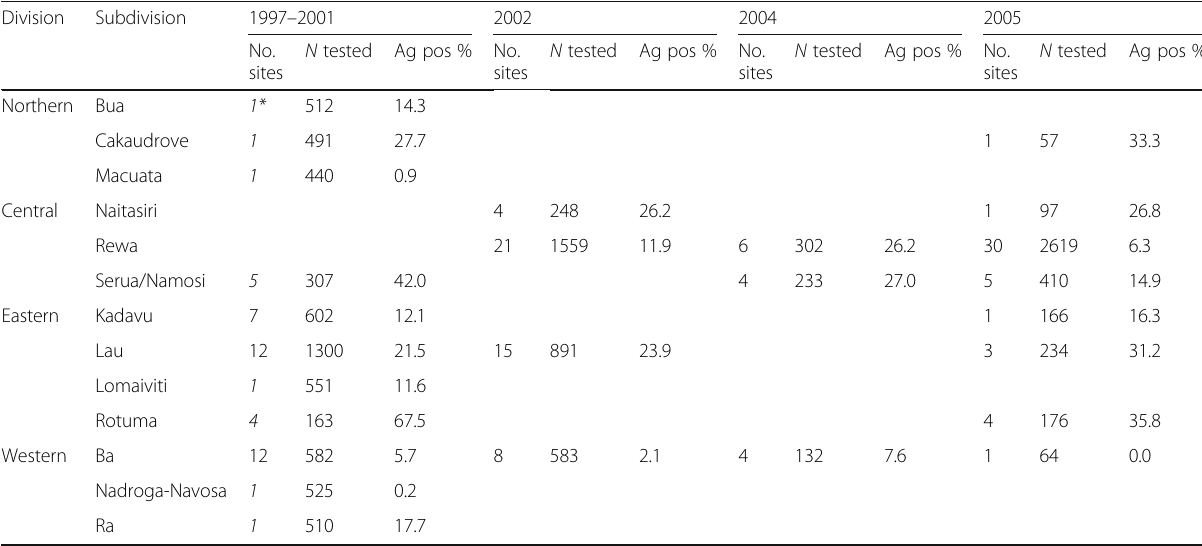
Table 5 Baseline and sentinel site surveys: antigen positive results by division and subdivision